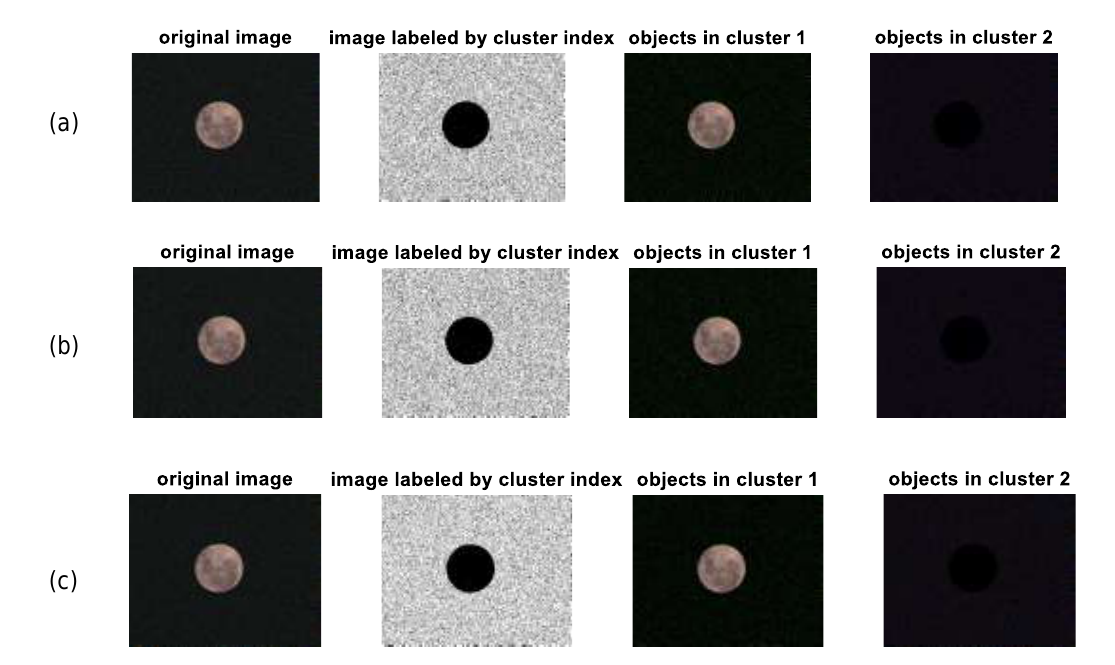
Figure 3. Natural image of moon with 2 clusters (a) result of FCM (b) result of SSFCM with 10% labelling (c) result of SSIFCM with 10%